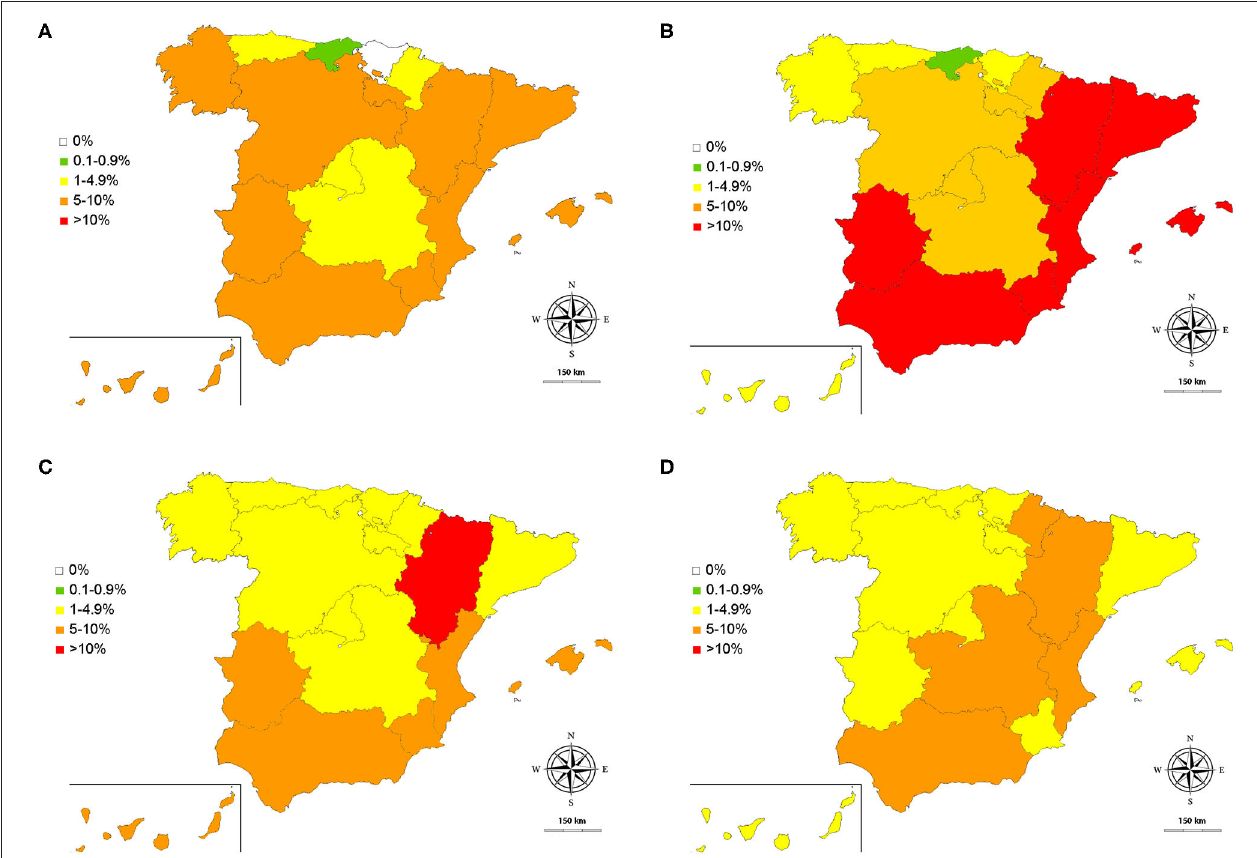
FIGURE 2 | Obtained prevalences for D. immitis (A) , and seroprevalences for L. infantum (B) , A. platys (C) , and E. canis (D) in Spain: 0% ( ); 0.1–0.9% ( ); 1–4.9% ( ); 5–10% ( ); > 10 ( ).